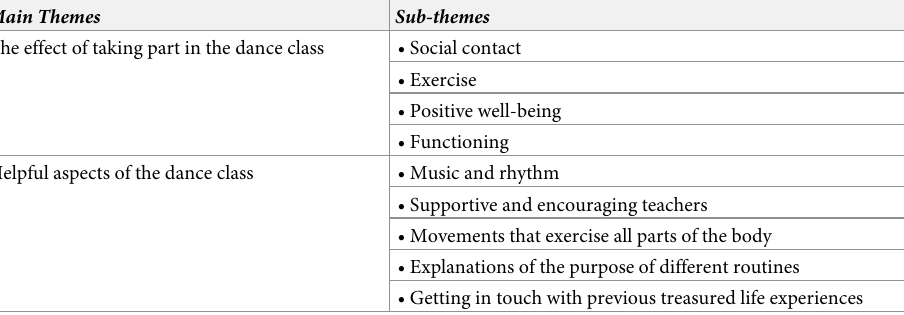
Table 2. Qualitative main and